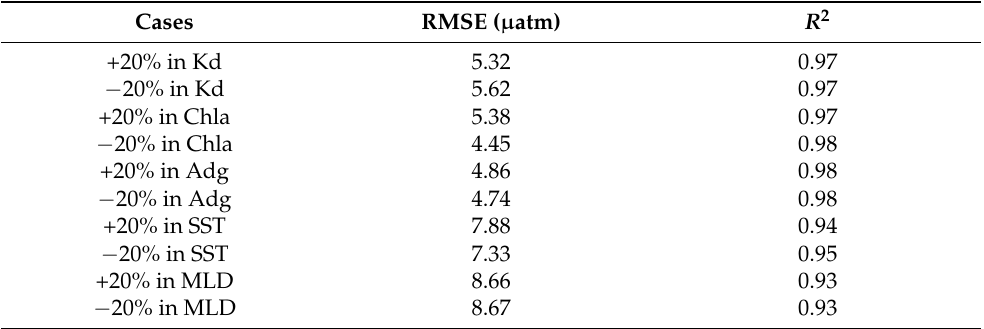
Table 4. Statistics of the sensitivity of the CatBoost pCO 2 model to uncertainties in each of the satellite- derived environment variables (Kd, Chla, Adg, SST and MLD) based on the validation dataset. Cases RMSE ( µ atm) R 2 +20% in Kd 5.32 0.97 − 20% in